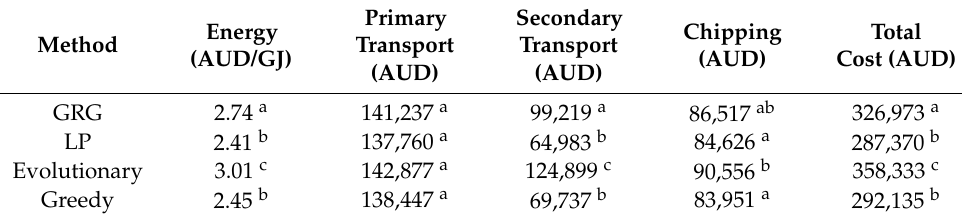
Table 5. Mean cost values for each tested method.